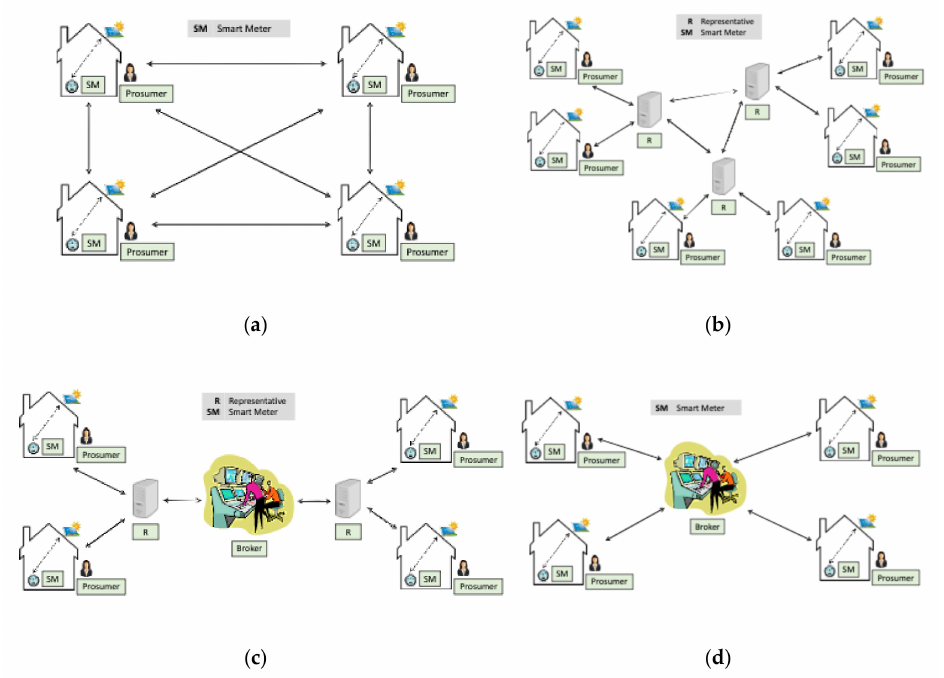
Figure 7. Future scenarios based on customer ownership and user involvement. Reproduced from [58], In Proc. of Workshop on Decentralized IoT Systems: 2020: ( a ) (S1) Prosumers participate directly in p2p electricity trading; ( b ) (S2) Representatives for passive prosumers participate in p2p trading; ( c ) (S3) Representatives for passive prosumers trade electricity via a broker; ( d ) (S4) Prosumers trade electricity with each other via a